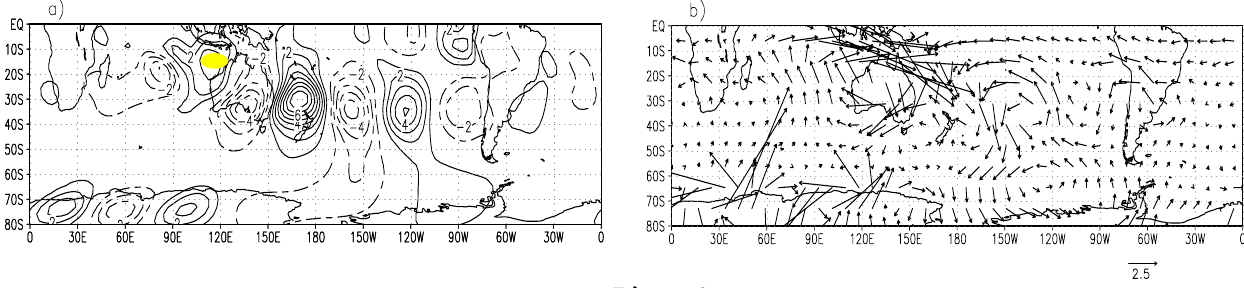
Fig. 9. (a) Meridional wind component anomalies (ms − 1 ) at 250hPa and (b) wind vector anomalies at 850hPa on day 10 of integration, corresponding to − σ basic state experiment with forcing at 120 ◦ E–15 ◦ S.